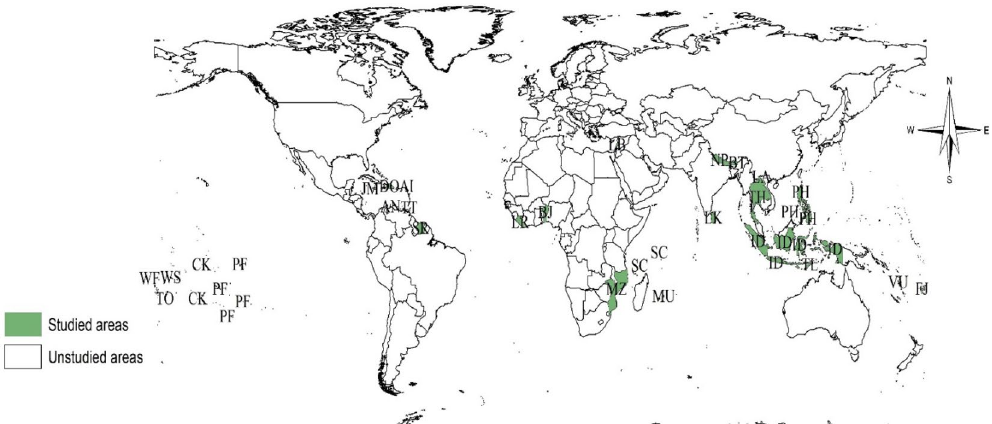
Figure 1. World map showing the study locations (Produced within ArcGIS version 10.8.1 using a base map obtained from https:// thema ticma pping. org/ downl oads/ world_ borde rs. php). Note: Anguilla (A.I.), Benin (B.N.), Bhutan (B.T.), Cook Islands (C.K.), Curacao (CC), Dominican Republic (D.O.), Fiji (F.J.), French Polynesia (P.F.), Indonesia (I.D.), Jamaica (J.M.), Lao People’s Democratic Republic (L.A.), Lebanon (L.B.), Liberia (L.R.), Mauritius (M.U.), Mozambique (M.Z.), Nepal (N.P.), Philippines (P.H.), Samoa (W.S.), Seychelles (S.C.), Sri Lanka (S.L.), Saint Lucia (L.C.), Suriname (S.R.), Thailand (T.H.), Timor-Leste (T.L.), Trinidad and Tobago (T.T.), Tonga (TO), and Vanuatu (V.U.), Wallis and Futuna Islands